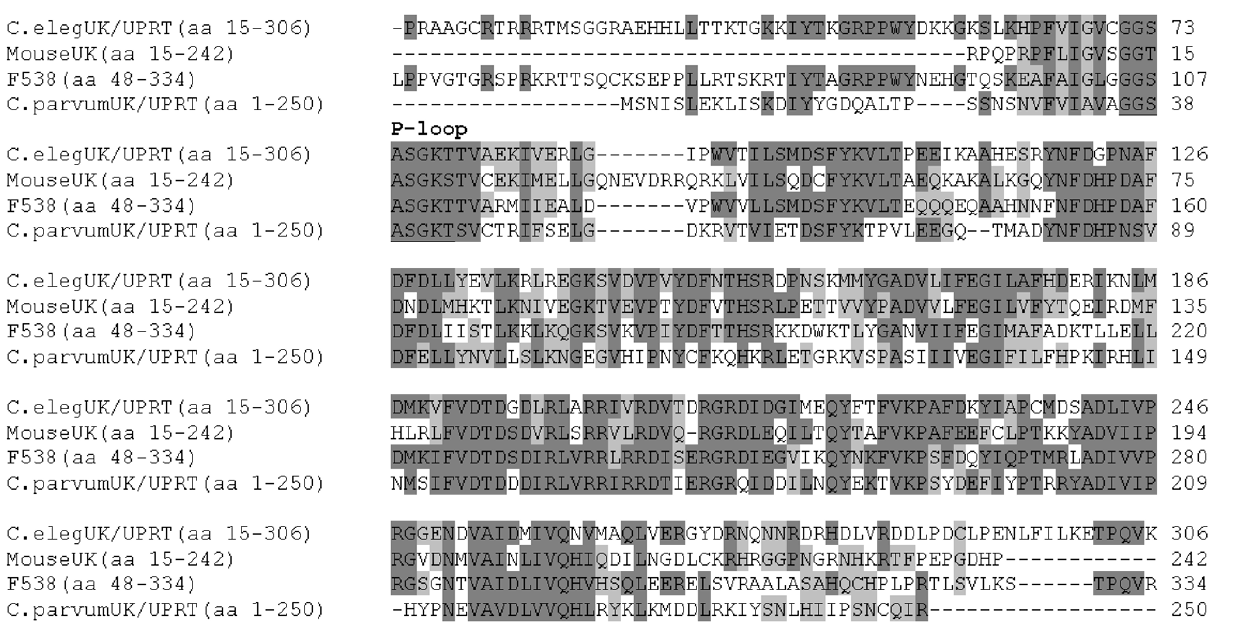
Figure 11 Multiple alignments of the N terminus of F538, mouse uridine kinase (P52263), UK/UPRT of Cryptosporidium parvum (AAG53652) and UK/UPRT of C. elegans (CAA93459). P-loop (ATP/GTP-binding site) is